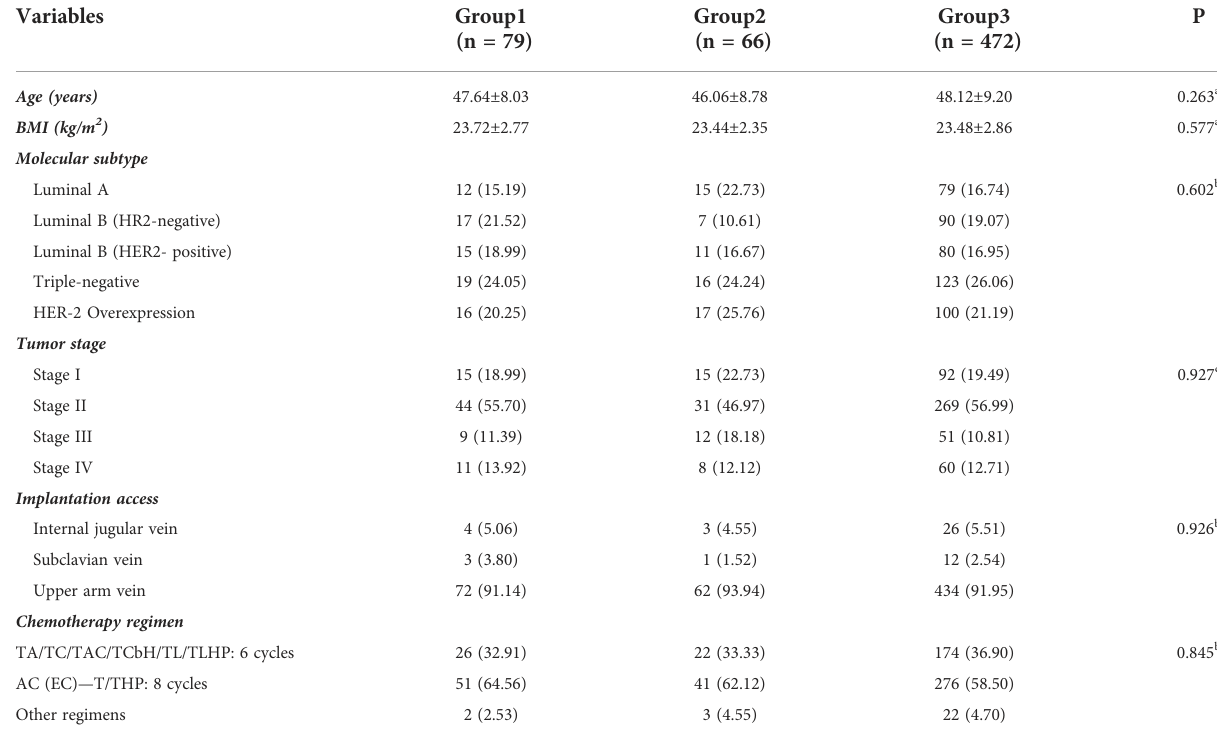
TABLE 1 Baseline information of patients who underwent TIVAP